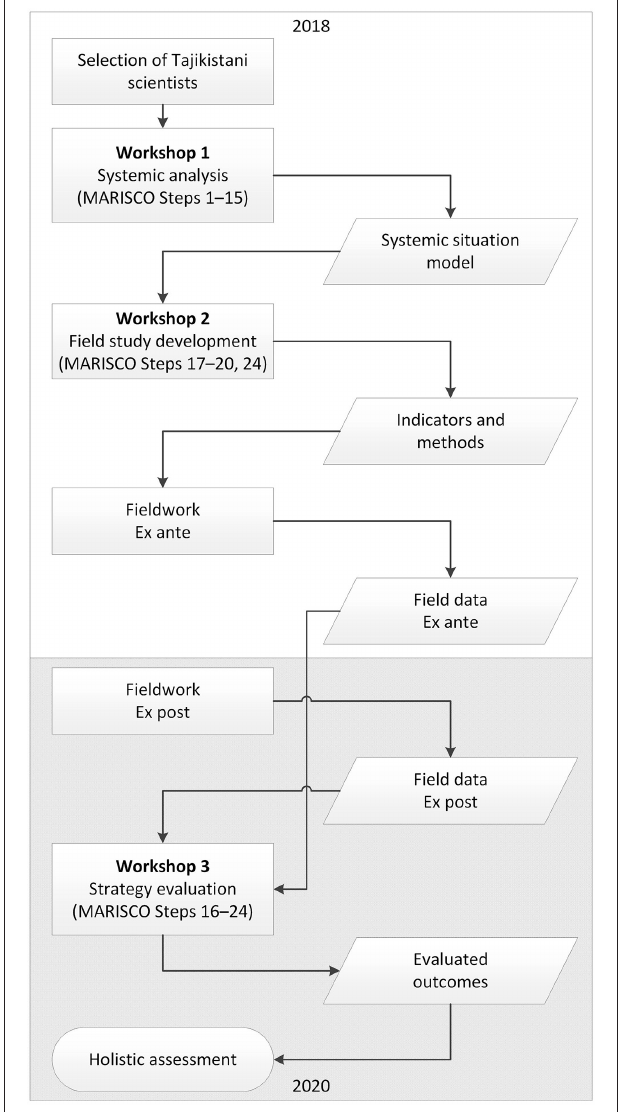
FIGURE 3 | Envisioned work process of the participatory approach. The following MARISCO steps were performed during the respective workshops: workshop 1–steps 1 to 15; Workshop 2–steps 17 to 20 and 24 (tentatively). According to the original work plan, the participants would have executed MARISCO steps 16 to 24 during Workshop 3. Instead, they only performed step